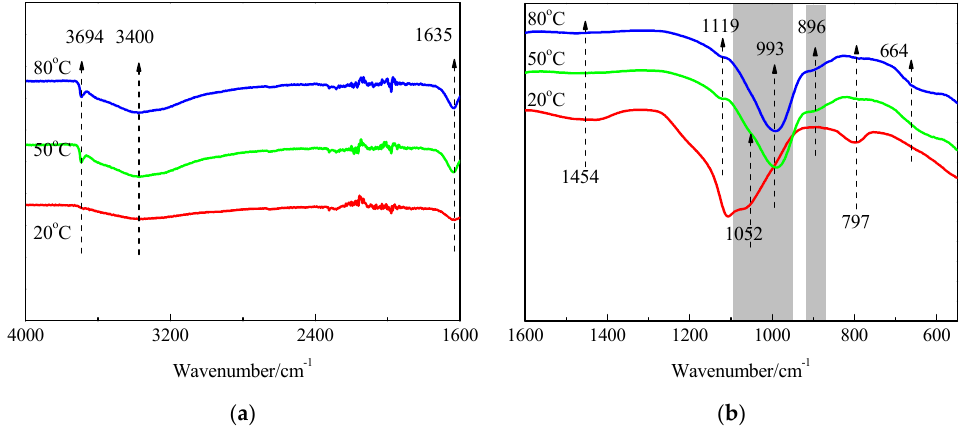
Figure 16. FTIR spectra of MgO-SF pastes prepared using MgO calcined at 1450 °C for 2 h after 14